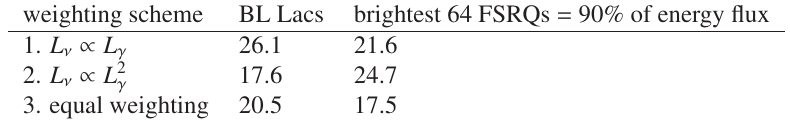
Figure 2. 90% CL upper limits for the TXS 0506 + 056 lightcurve correlation analysis. They are given in terms of number of neutrino events assuming a spectrum of γ = 2. The upper limit is shown as a function of the photon flux threshold, ranging from Φ 0 = 0 where signal neutrinos correlate to the whole lightcurve, up to thresholds where they arrive only during the highest parts of the 2017 flare. Vertical lines show the best fit thresholds, in solid without IceCube-170922A, dashed with it.